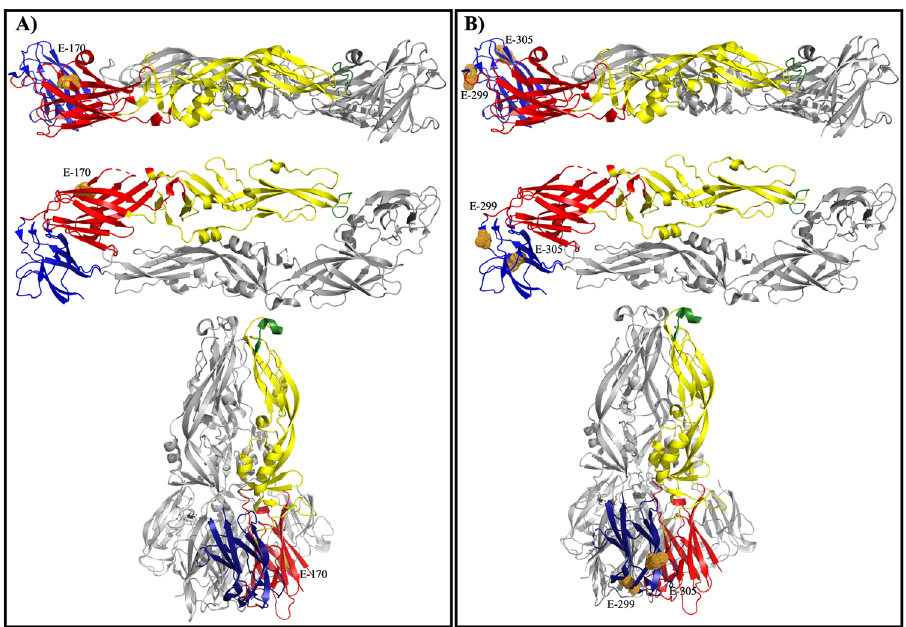
Fig. 5 mAb epitopes and MRP binding domains overlap on YFV E protein. Residues important to the WT mAb 117/liver MRP binding ( A ) and vaccine mAb 411/brain MRP binding ( B ) were mapped onto the E protein prefusion (displayed from side and top) and post-fusion